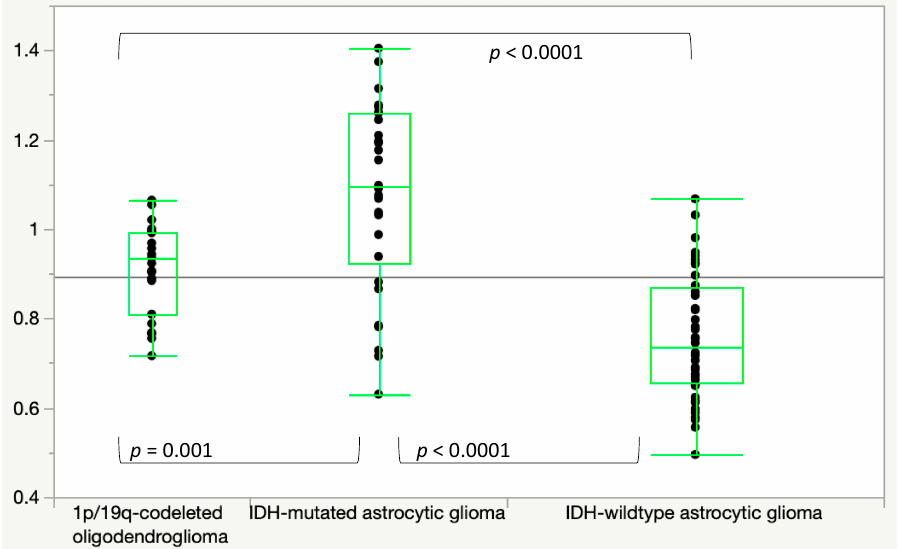
Figure A1. Distribution of the average ADC values using b-values of 500 s/mm 2 and 2500 s/mm 2 , classified into the three molecular glioma groups: ADC, apparent diffusion coefficient.